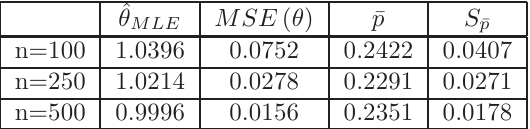
Simulations for Exponential AFT model, Binomial